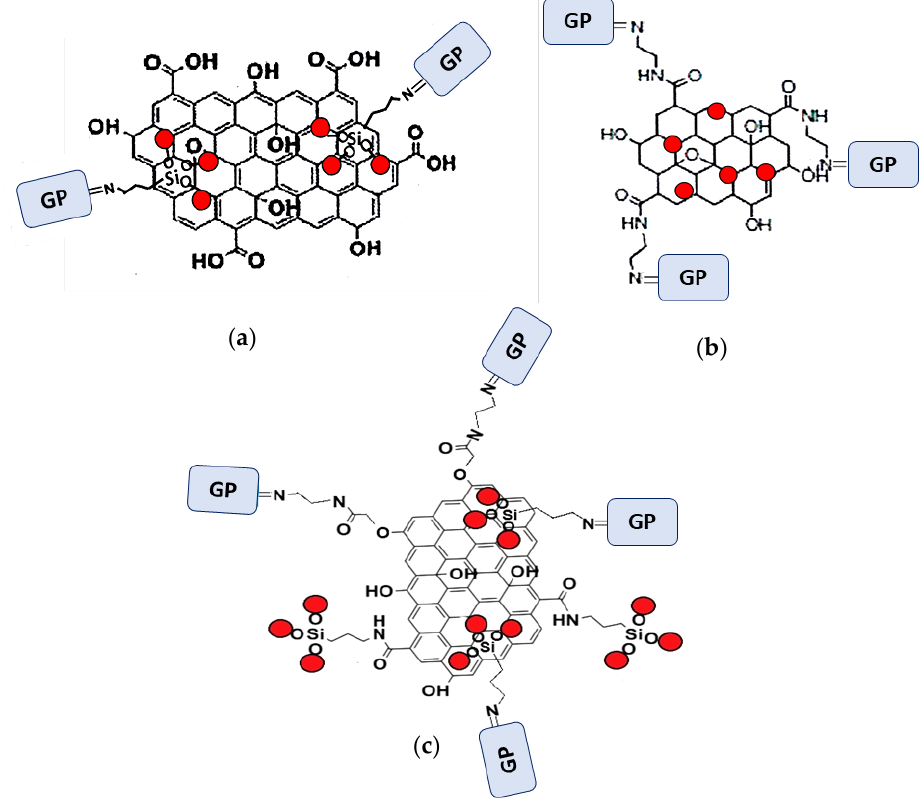
Figure 3. ( a ) Functionalized MNPs–GO structure synthesized by Method 1; ( b ) functionalized MNPs–GO structure synthesized by Method 2 and ( c ) functionalized MNPs–GO structure synthesized by Method 3. GP: Functional Group.